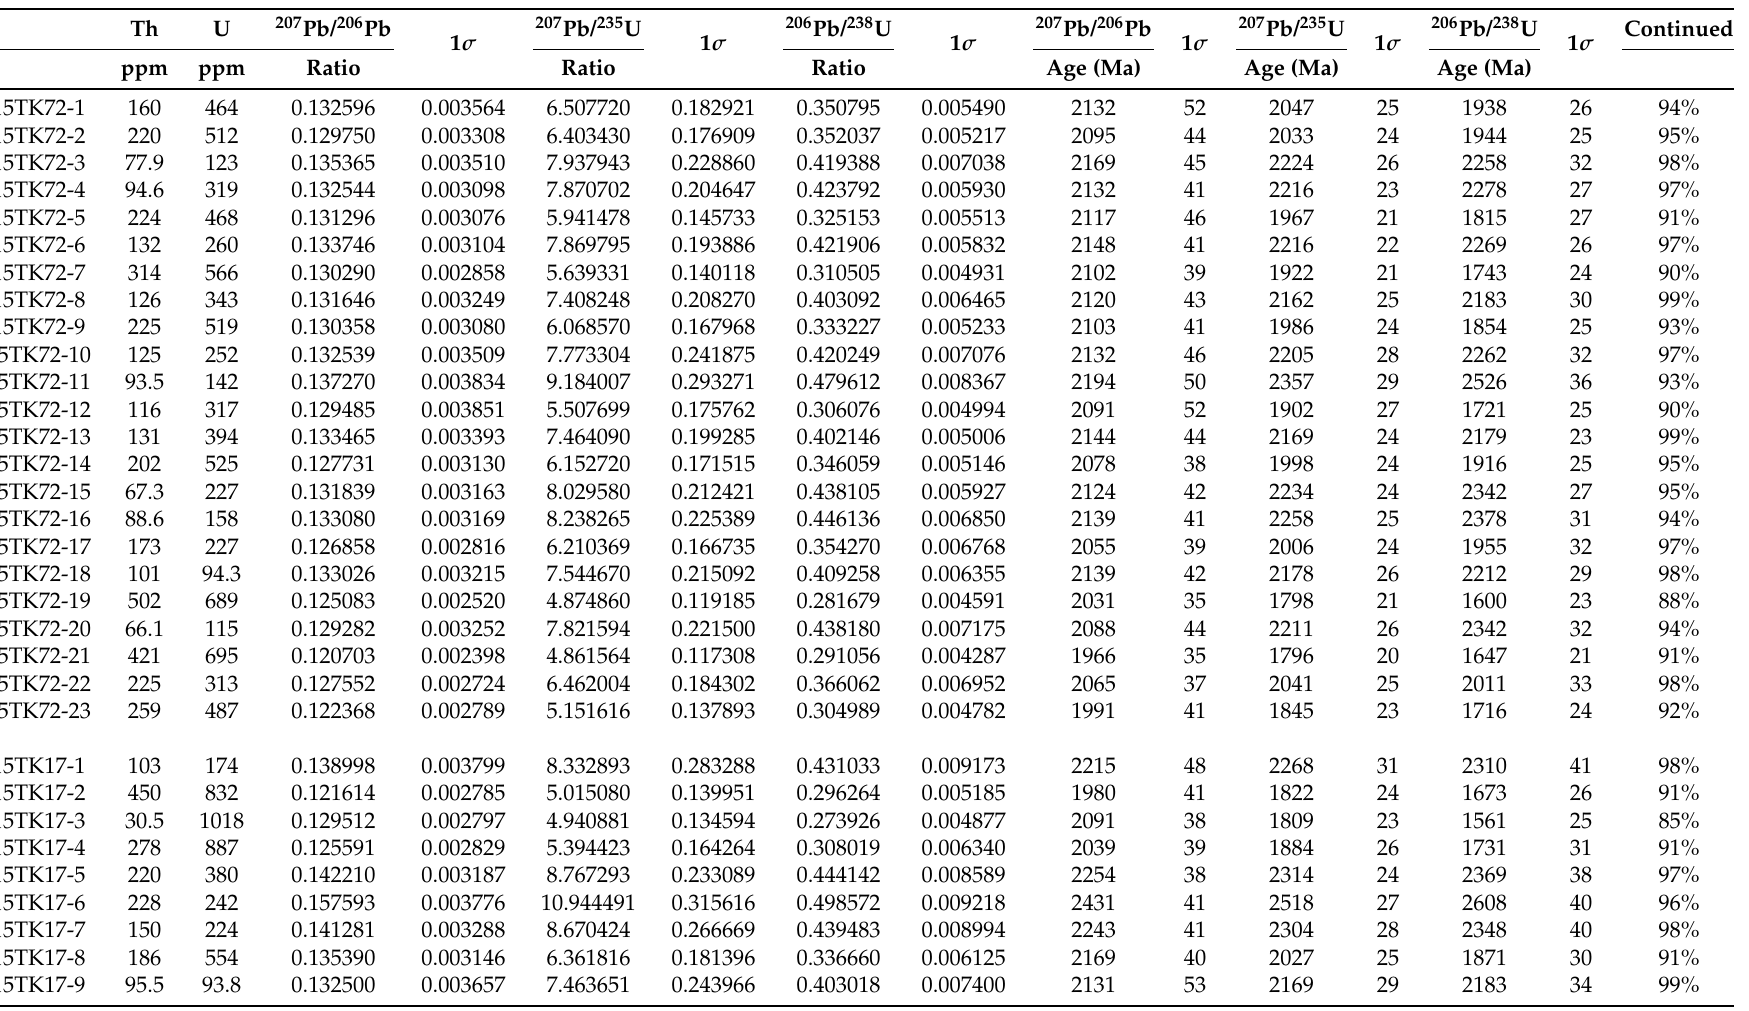
Table 1. Results of zircon U-Pb dating on Tongkuangyu monzogranitic porphyries, Zhongtiao mountain, North China